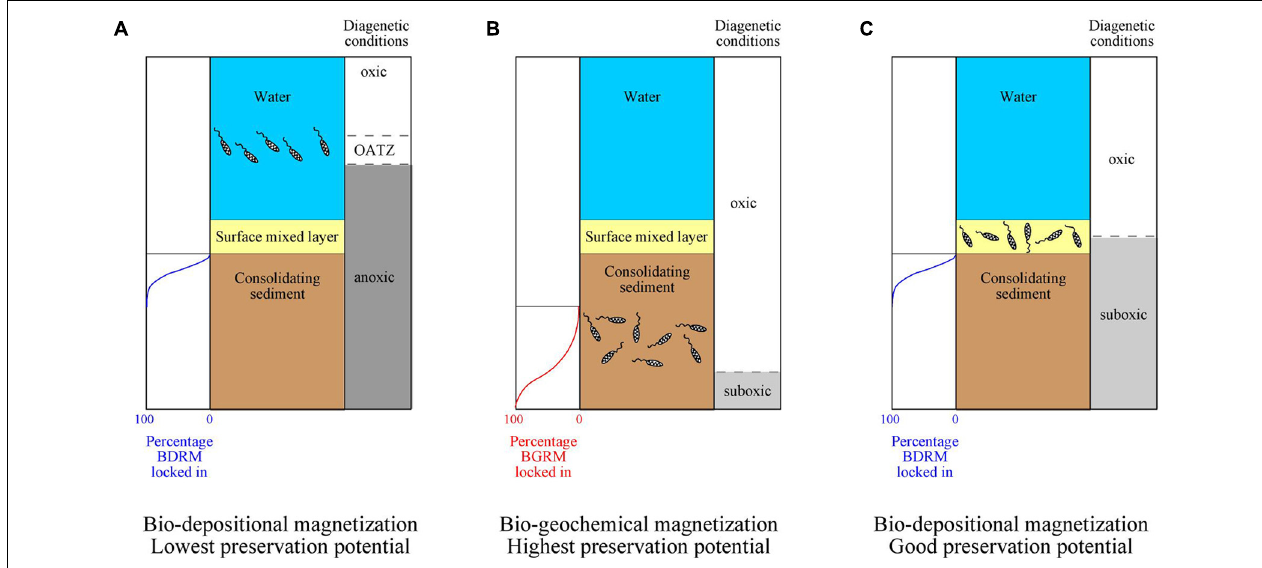
FIGURE 1 | Schematic diagrams of paleomagnetic and environmental signals recorded by magnetofossils. (A) Magnetofossils produced by magnetotactic bacteria that lived in the water column will behave effectively as detrital particles within the surface mixed layer, and will retain a bio-depositional remanent magnetization (BDRM). Location of the oxic–anoxic transition zone (OATZ) in the water column implies strong anoxic conditions that will result in low preservation potential due to reductive dissolution during subsequent burial. (B) Magnetofossils produced by magnetotactic bacteria